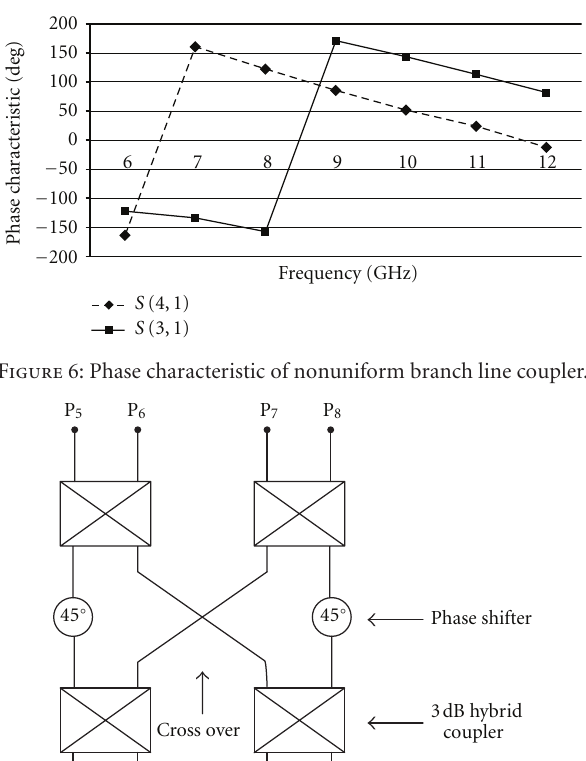
Figure 10: Final layout of the proposed wideband Butler Matrix 4 ×